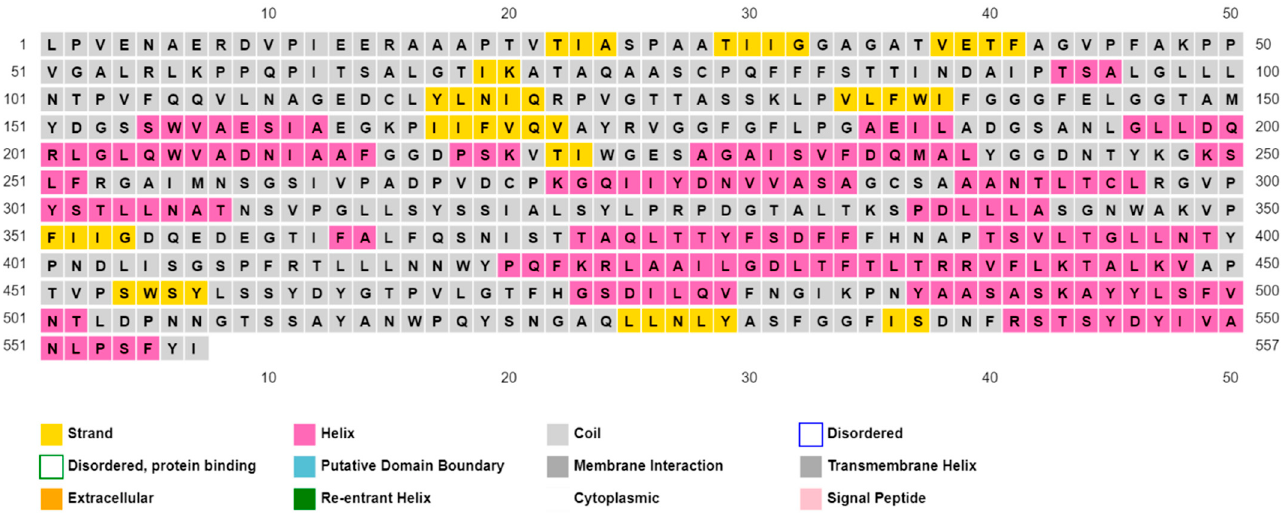
Figure 4. Alpha helices in B. cinerea lipase. Alpha helices have been depicted by PSIPRED in B. cinerea lipase. A total of eighteen alpha helices were present in the protein structure.